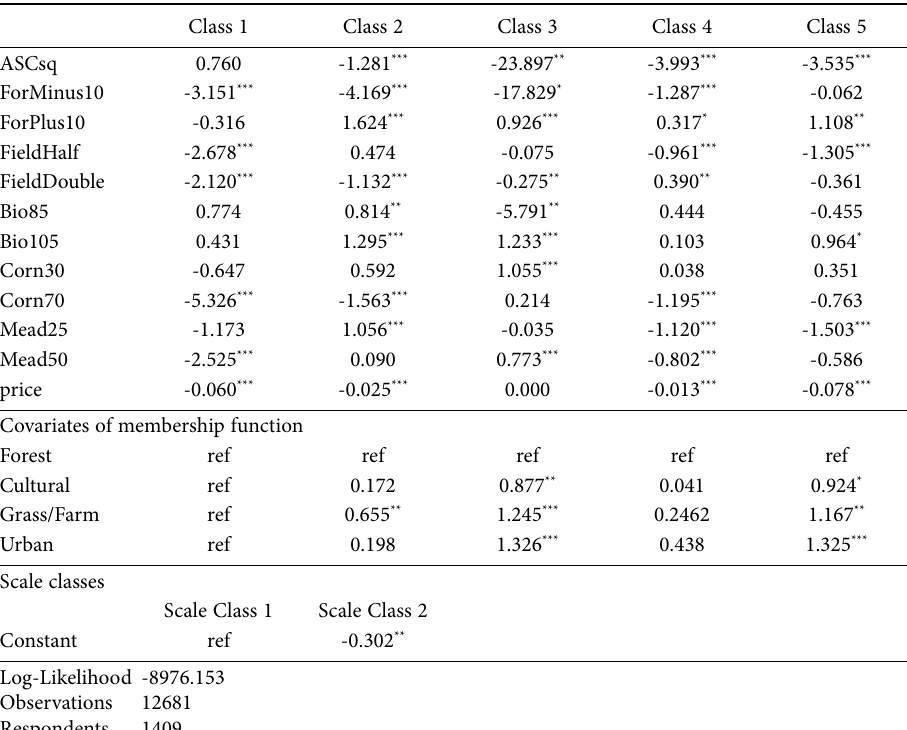
Table 5. Latent class model with five